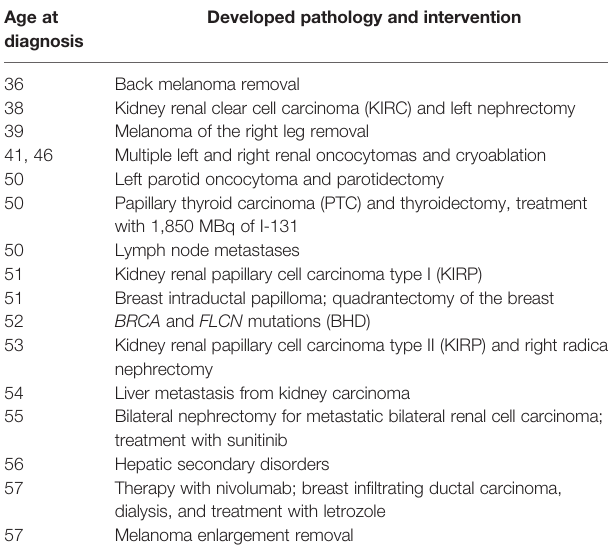
Developed pathology and